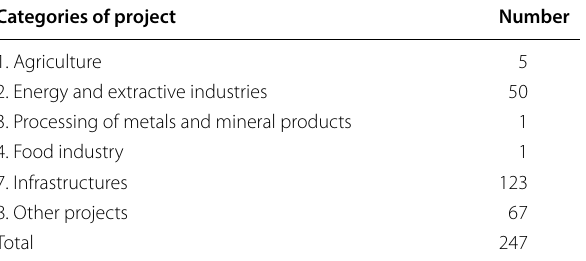
Table 4 Screening: categories and number of projects Categories of